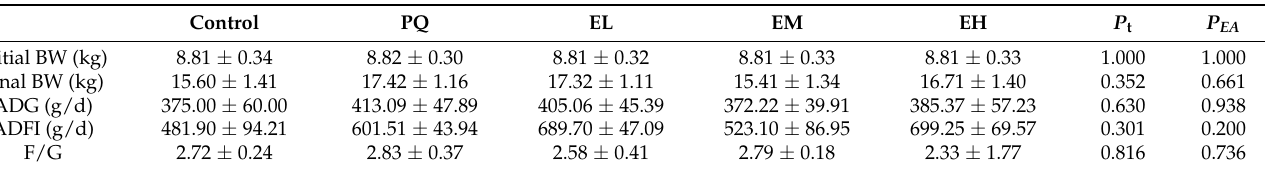
Table 3. Growth performance of piglets 1,2